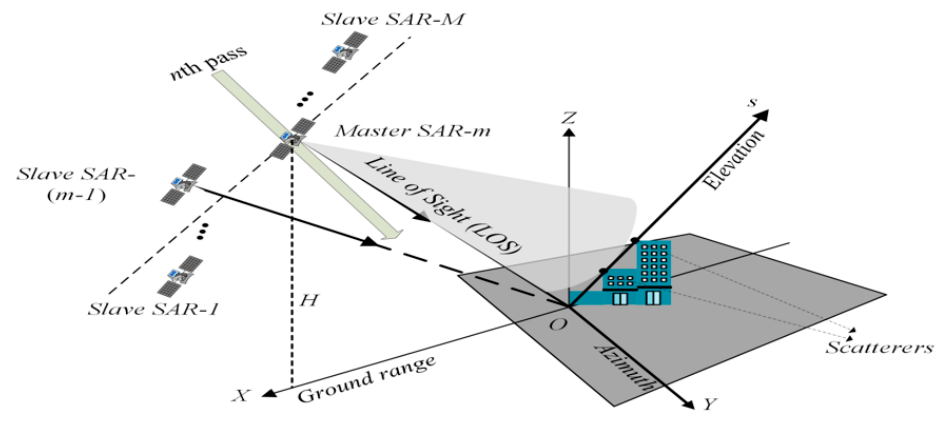
Figure 1. System geometry of differential synthetic aperture radar tomography (D-TomoSAR).